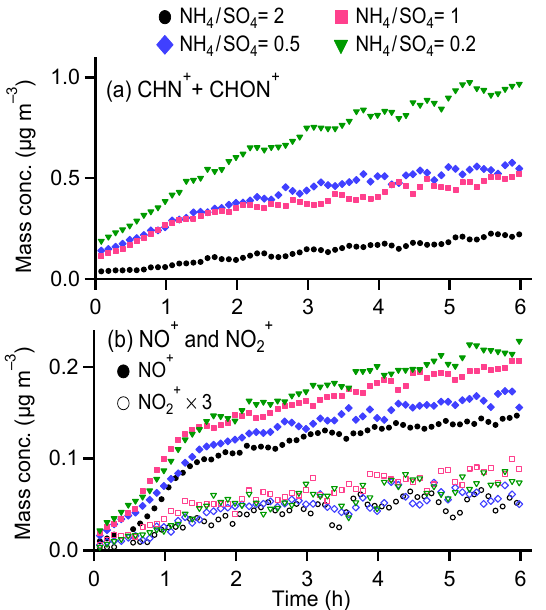
Figure 7. The temporal variations of (a) total N-containing organic fragments (the sum of C x H y N + z and C x H y O z N + p ) and (b) NO + and NO + fragments for experiments using ammonium sulfate and 2 acidic particles under high-NO x